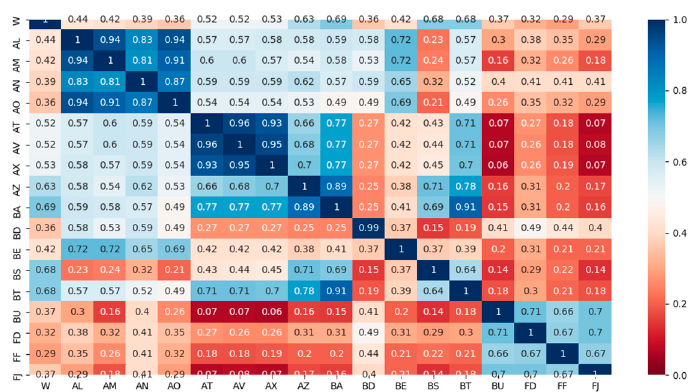
Figure 5. Correlation analysis of dataset 3.